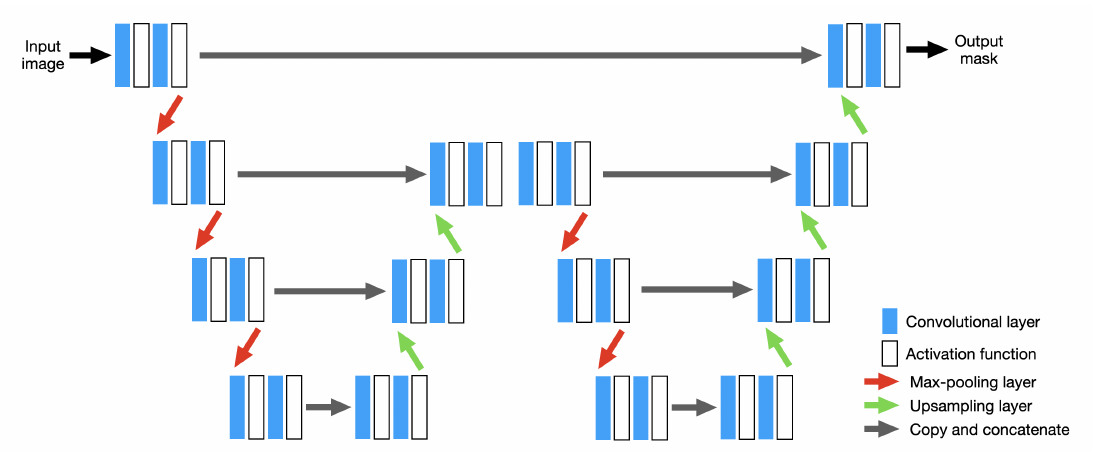
Figure 6. XNet architecture using 3 × 3 convolutional layers and ReLU activation functions. Filter depths of each level are given in Table